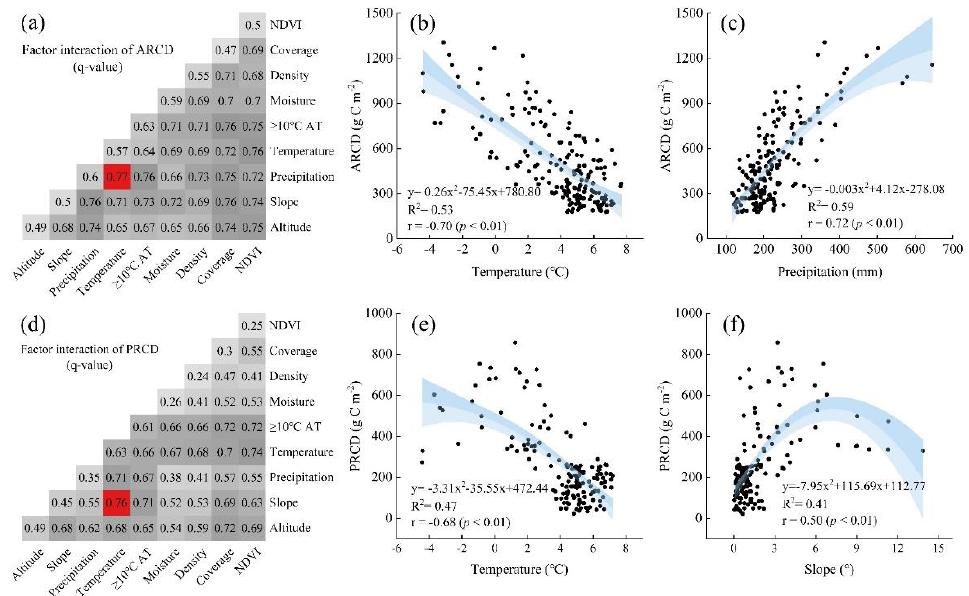
Figure 4. Crucial drivers of actual root carbon density (ARCD) and potential root carbon density (PRCD) in the 0–30 cm soil layer in grassland of Altay Prefecture. Based on major two-factor interactions ( a ), the trend for ARCD with increase in temperature ( b ) and precipitation ( c ) was determined. Based on the two-factor interactions ( d ), the trend for PRCD with increase in temperature ( e ) and slope ( f ) was determined. Shaded bands indicate the 95% confidence interval; ≥10 °C AT, ≥10 °C accumulated temperature; q-value, factor detection and interaction factor detection results; r, Pearson correlation coefficient.